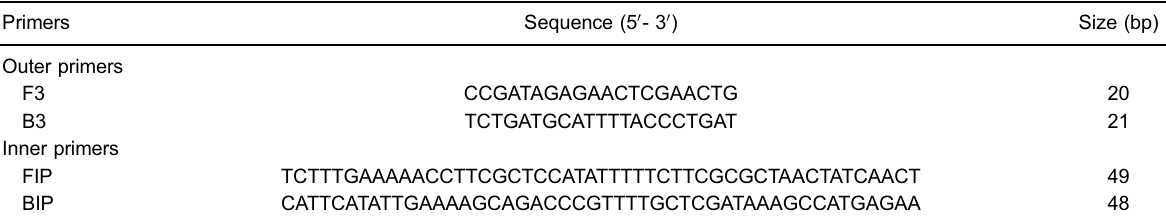
Table 1. Primers for the ampli fi cation of the ureR_1 gene.